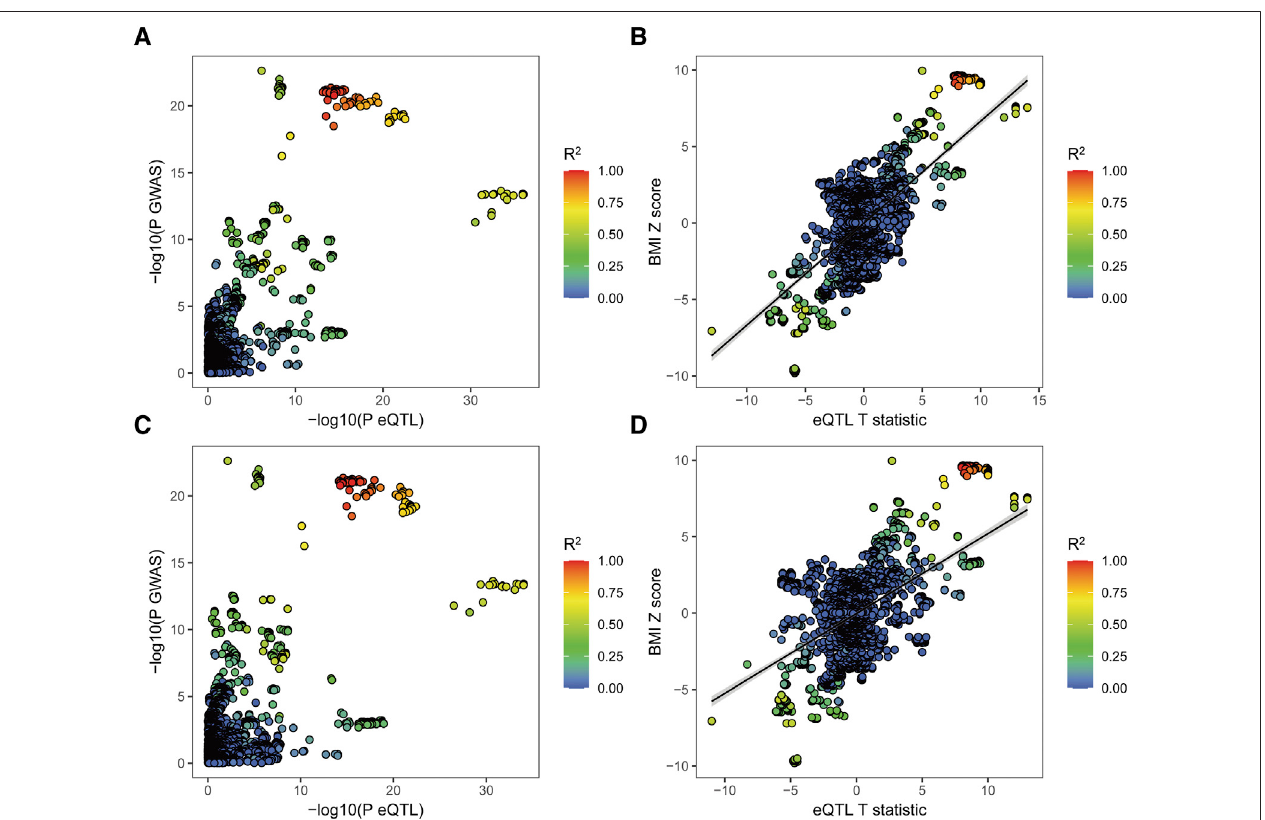
FIGURE 2 | Colocalization of the eQTL and GWAS associations for MAP2K5 . (A), Scatterplot shows the overlap of GWAS and eQTL associations for genetic variantsof MAP2K5 insubcutaneousadiposetissue.The Y -axisrepresentstheGWAS p valueona-log10scaleforBMIThe X -axisrepresentsthesubcutaneousadipose tissue eQTL p value on a -log10 scale for MAP2K5. (B) , Scatterplot shows SNP associations between BMI and MAP2K5 expression in subcutaneous adipose tissue. The Y -axis represents variants associated with BMI risk ( Z score). The X -axis shows eQTLs associated with MAP2K5 gene expression (t statistic). (C) , Scatterplot shows the overlap of GWAS and eQTL associations for genetic variants of MAP2K5 in whole blood. The Y -axis represents the GWAS p value on a -log10 scale for BMI. The X -axis represents the whole blood eQTL p value on a -log10 scale for MAP2K5 . (D) , Scatterplot shows SNP associations between BMI and MAP2K5 expression in whole blood. The Y -axis represents variants associated with BMI risk ( Z score). The X -axis shows eQTLs associated with MAP2K5 gene expression (t statistic). The extent of linkage disequilibrium for all SNPs with rs7175517 is indicated by red colors.